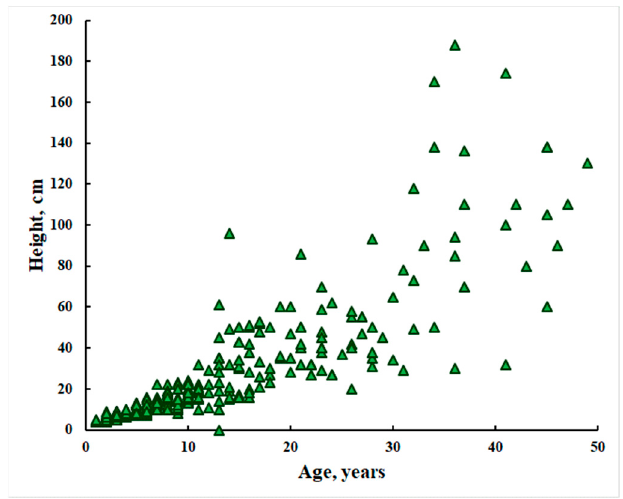
Figure 5. The relationship between age and height for the studied undergrowth of Pinus sibirica (the N value is 579). N value is